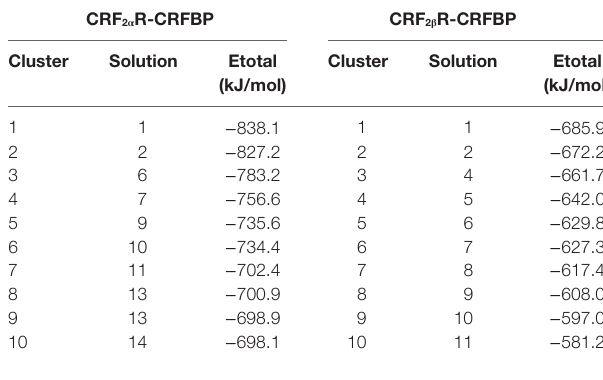
TaBle 2 | Protein–protein docking for CRBP binding to CRF2 subtype receptors.